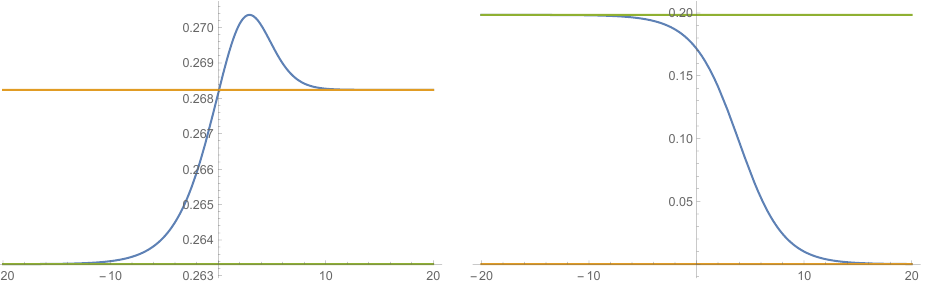
(cid:96) . The scalar vevs asymptote to